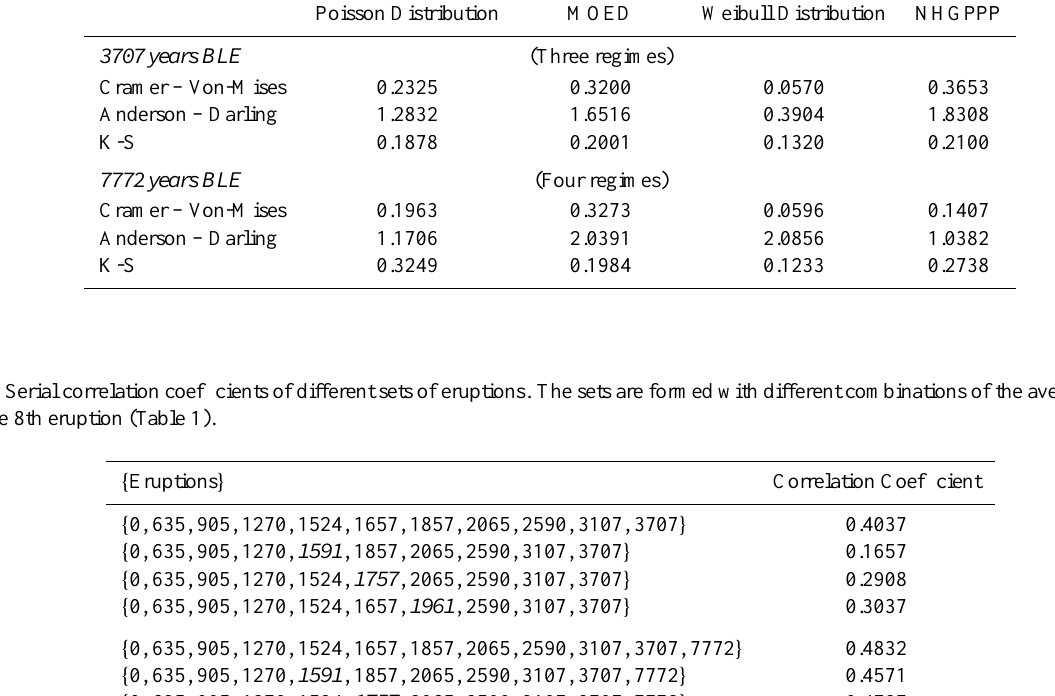
(Table 8). Independence requires serial correlation